Question: What form of chart is displayed?
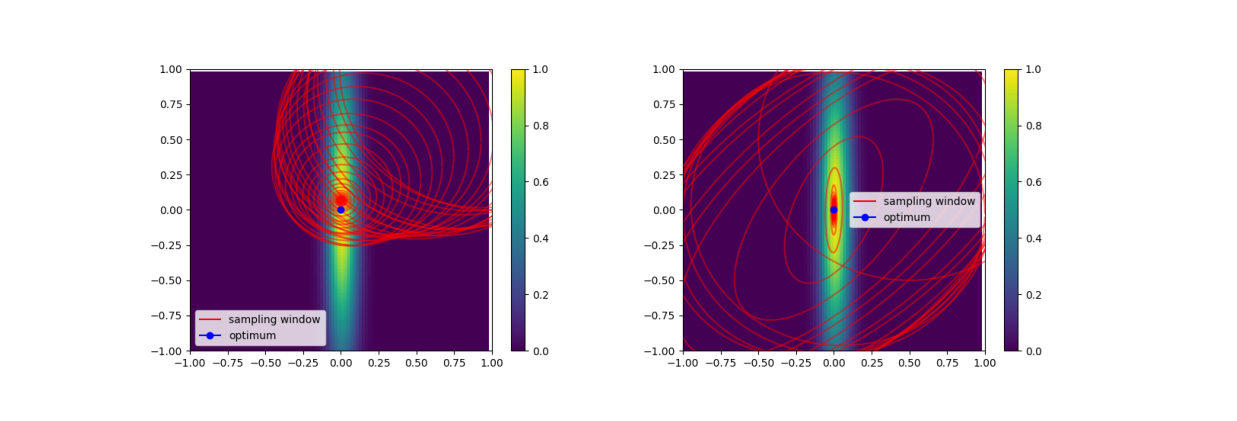
Answer: heatmap